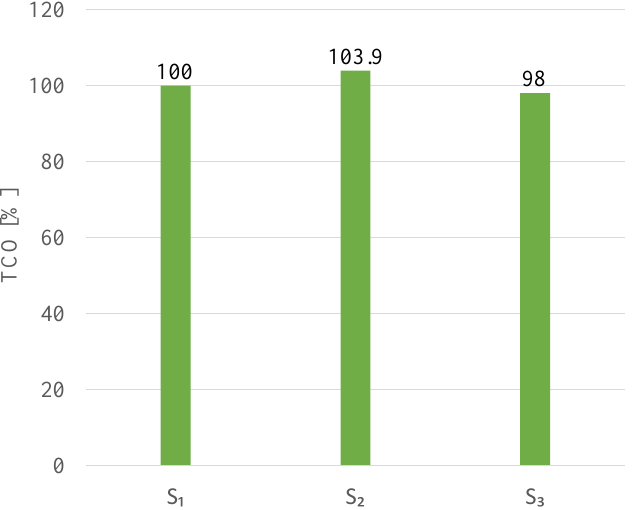
Figure 16. Comparison of normalized TCO between S 1 , S 2 and S 3